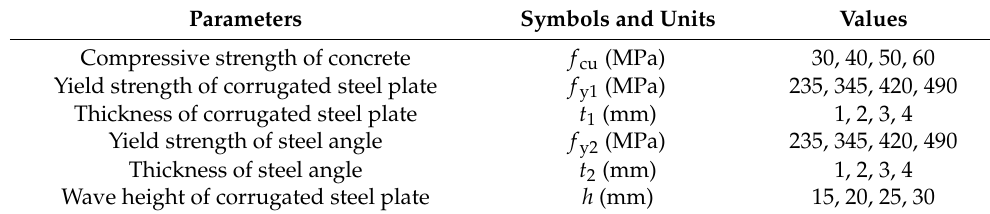
Table 2. Parameters of FE model.